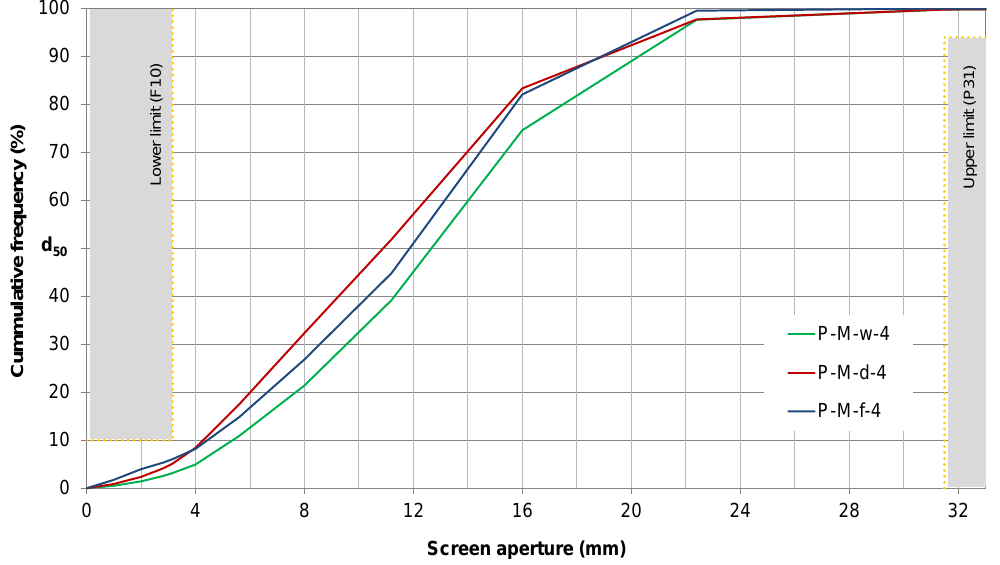
Figure 9. Particle size distribution for fine wood chips from poplar, willow and black locust and standard ranges according to EN ISO 17225-1; Labelling of trials: see Table 1.